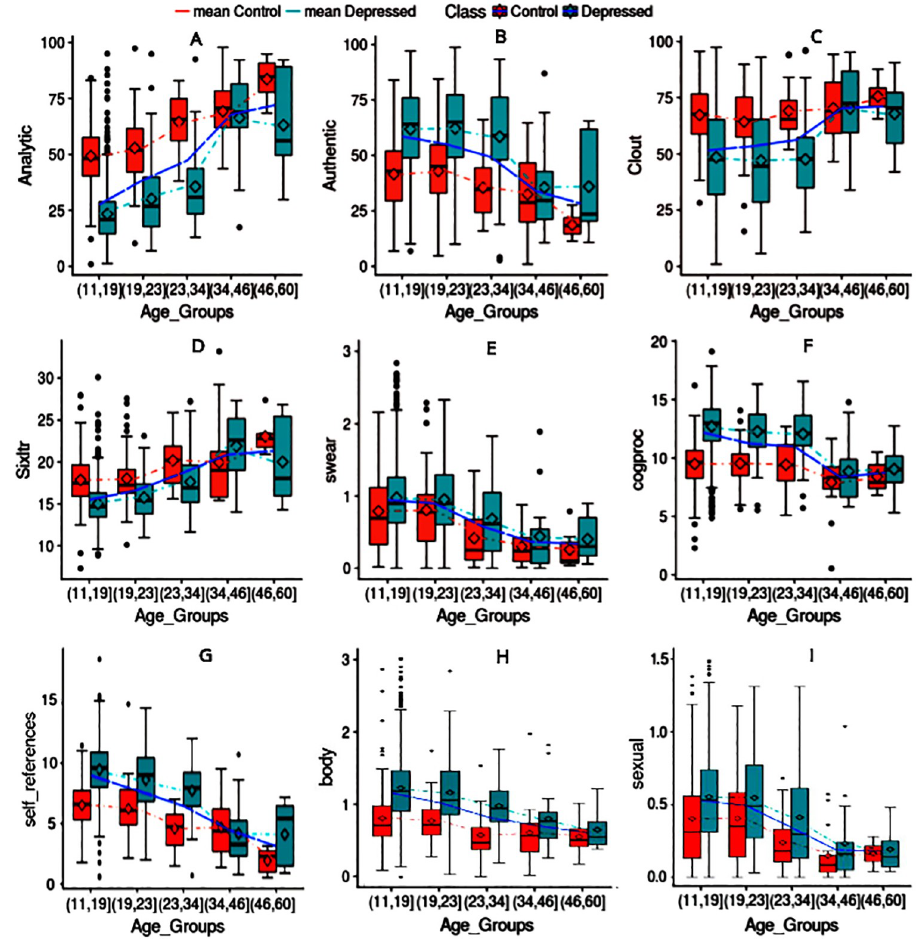
Fig 4. Characterizing linguistic patterns in two aspects: Depressive-behavior and age distribution.